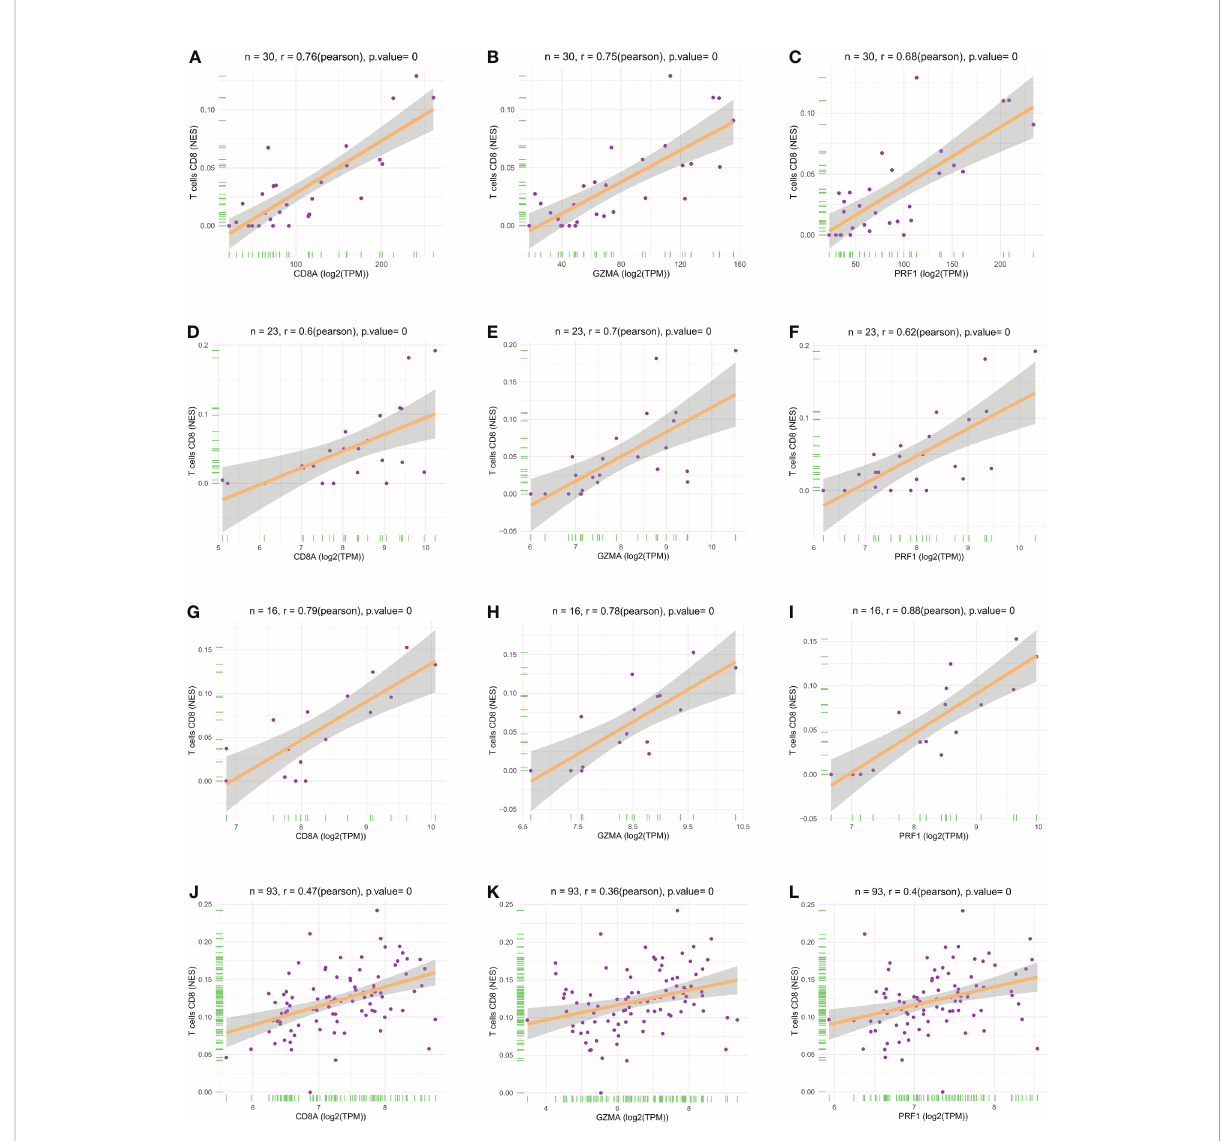
FIGURE 4 Scatter plots of hub gene expression versus CD8+ T cell in fi ltration levels in three different datasets: (A-C) GSE55235. (D-F) GSE55457. (G-I) GSE55584. (J-L) GSE1919 and